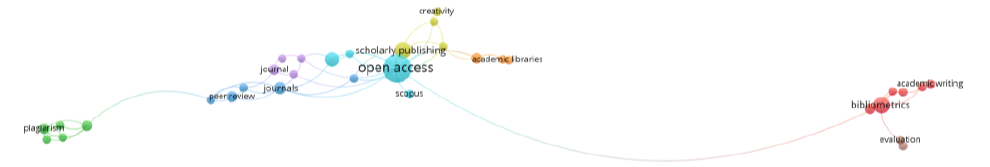
Figure 5. Top keyword network (n = 31, occurrence > 2) in the period 2013–2017. Source: VOSViewer.